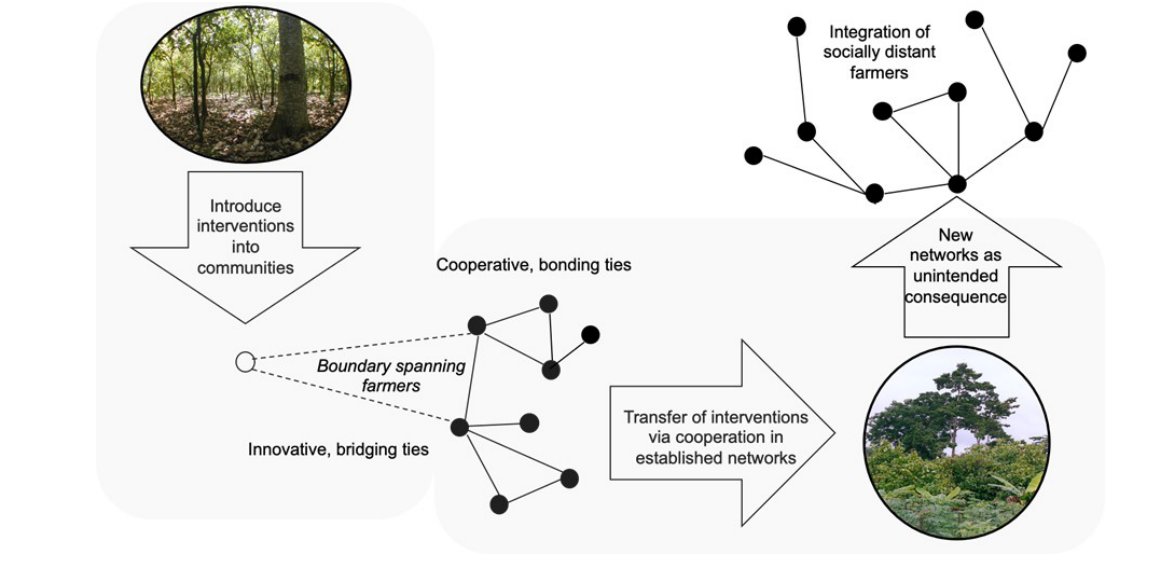
Fig. 3 . Two network types are functioning in agrobiodiversity adoption: established networks linked to institutions and emergent networks formed by observation and advice seeking. Agrobiodiversity interventions, such as the transformation of cocoa monocultures to cocoa agroforestry systems with the inclusion of shade trees, can be introduced via boundary-spanning farmers and disseminated to the larger community via established networks, and farmer-to-farmer learning. New information networks can also emerge from agrobiodiversity interventions via observation of successful farming practices thus including socially distant